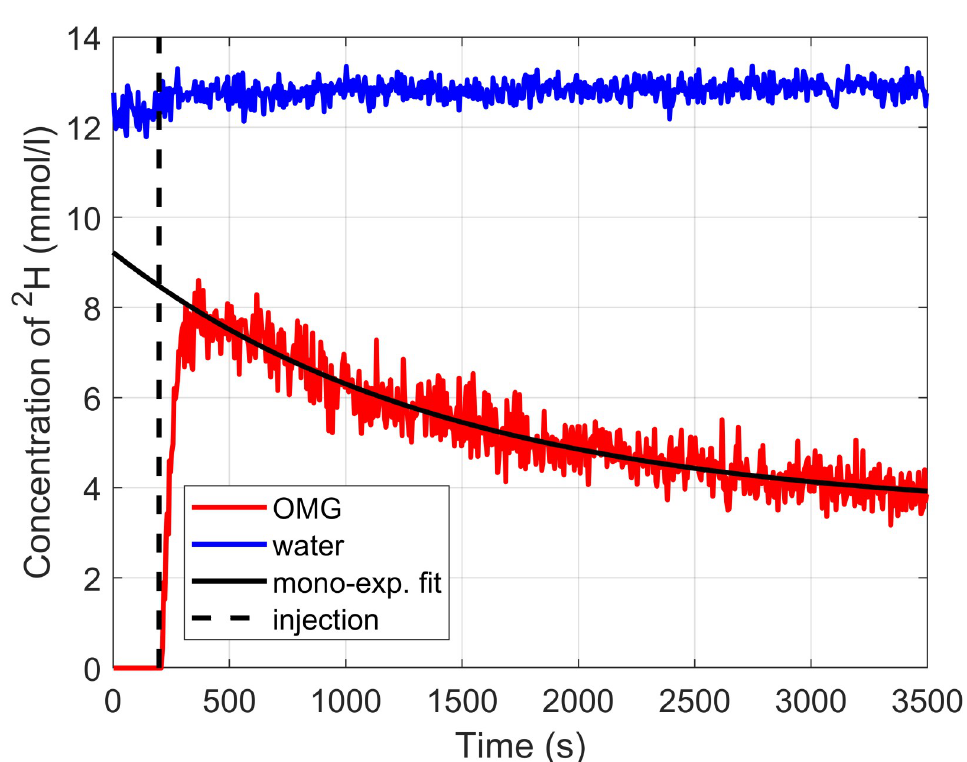
Fig 3. Time evolution of the signal amplitudes in the deuterium spectrum. Signal amplitudes of the different peaks in the deuterium spectrum are shown for the whole time course of the experiment (result from rat 3). The concentration of 2 H within both chemical environments (water and OMG) is given. The concentration of OMG itself can be obtained by dividing the data by its degree of deuteration, which is 2.9. The injection of OMG took place at t = 200 s and was followed by a steep increase of the glucose signal. The washout of OMG was fitted with a mono-exponential function with offset, taking into account the data from its maximum (at t = 368 s) until the end.